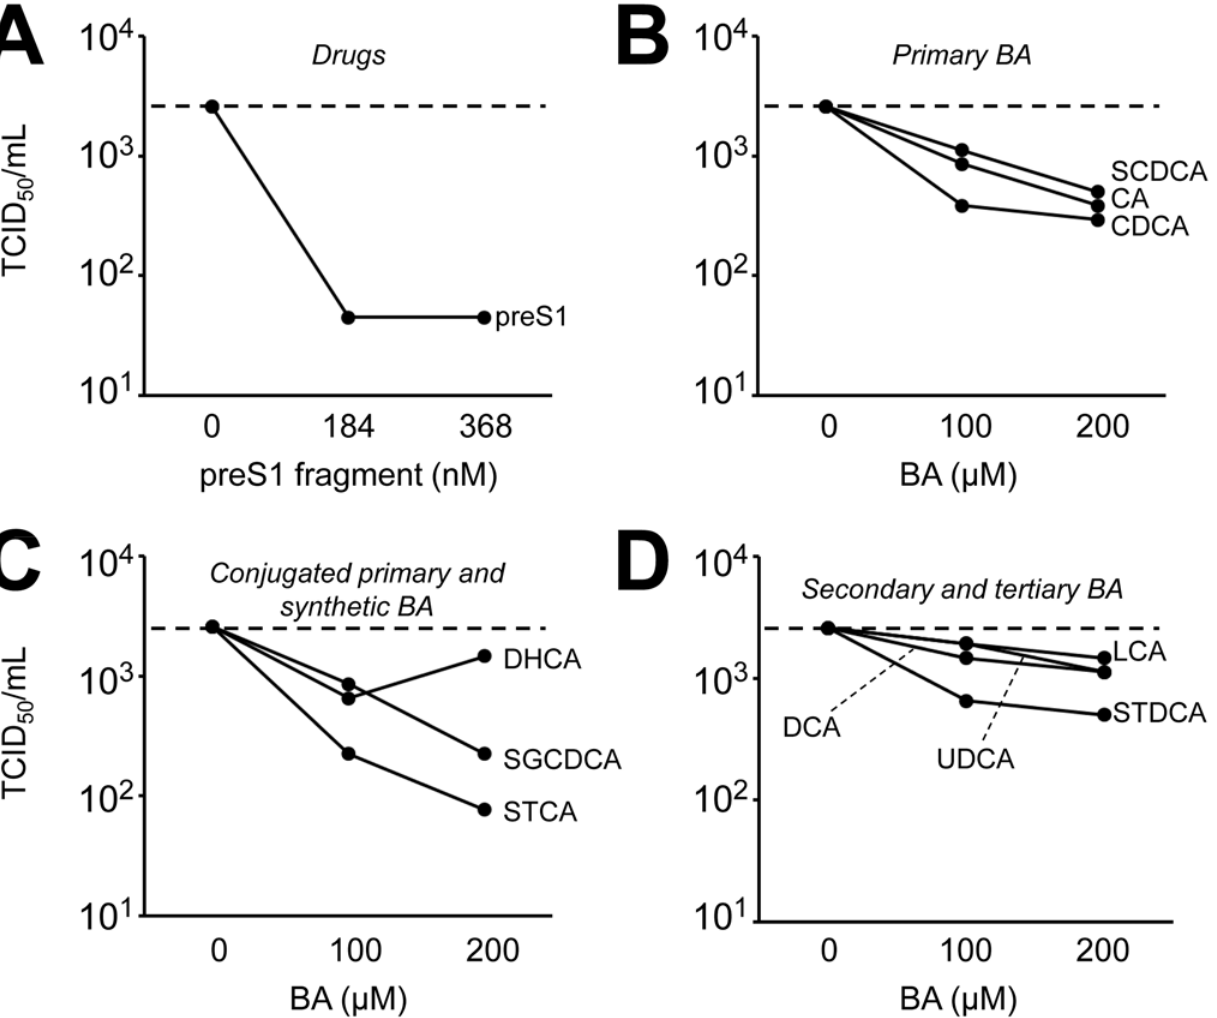
Fig 2. Quantification of inhibition of HDV cell entry by BA. HuH-7/hNTCP cells were seeded in 96-well plates and infected with HDV in the presence of (A) 184 or 368 nM or preS1 peptide or (B-D) 100 or 200 µ M of BA. Cells were exposed to virus +/- BA for 6 h, washed and then kept in regular media for another 5 days. TCID 50 values were determined as described in the method section. Each data point is based on 48 wells and a representative of two independent experiments is